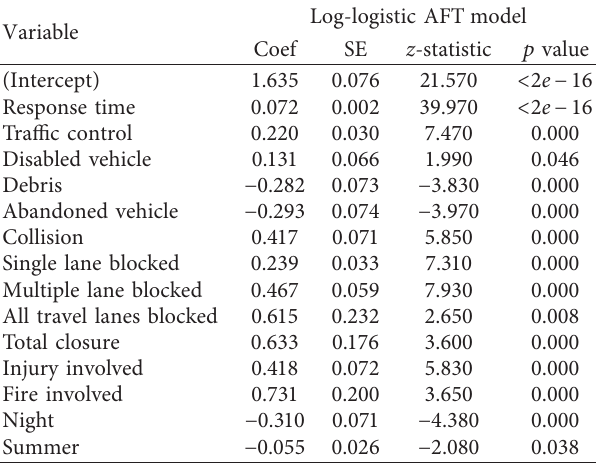
Table 4: The estimated parameters for the log-logistic AFT